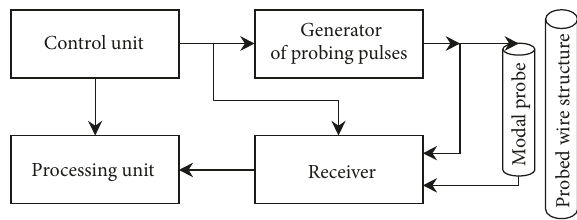
Figure 1: Block diagram of the modal probing